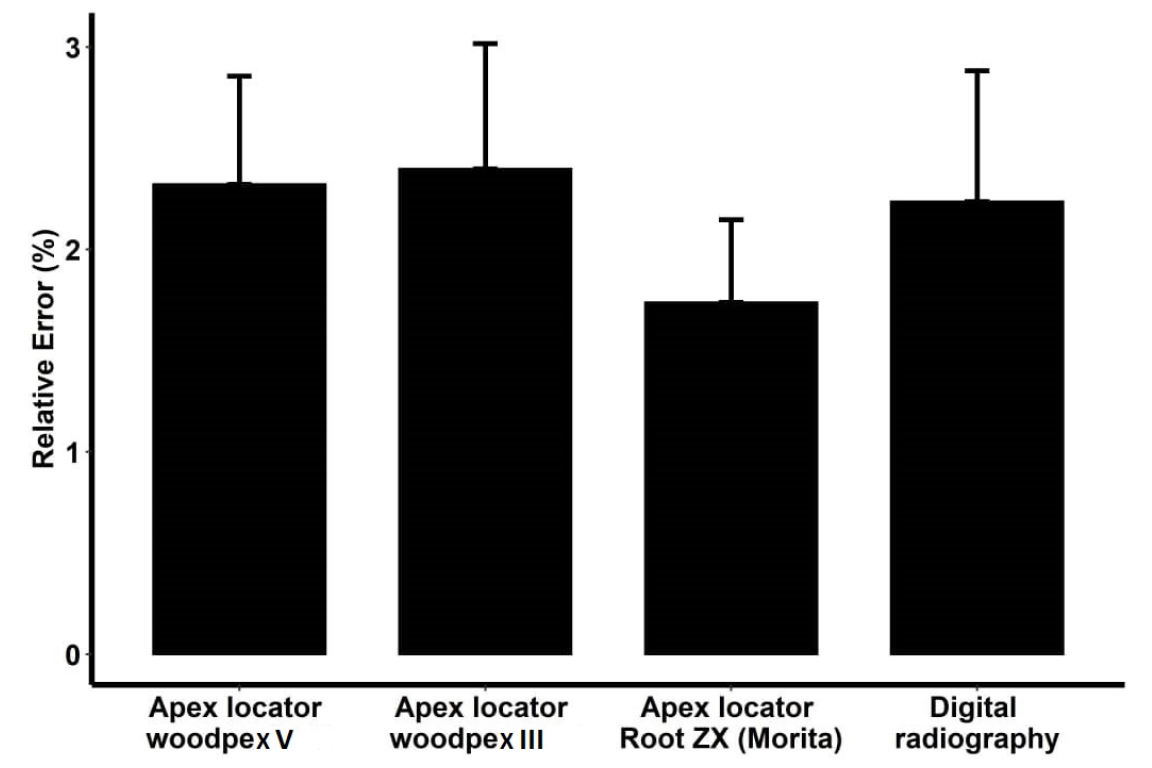
Figure 5. Relative error of the four modalities based on the actual working length in the samples with lateral apical foramen.